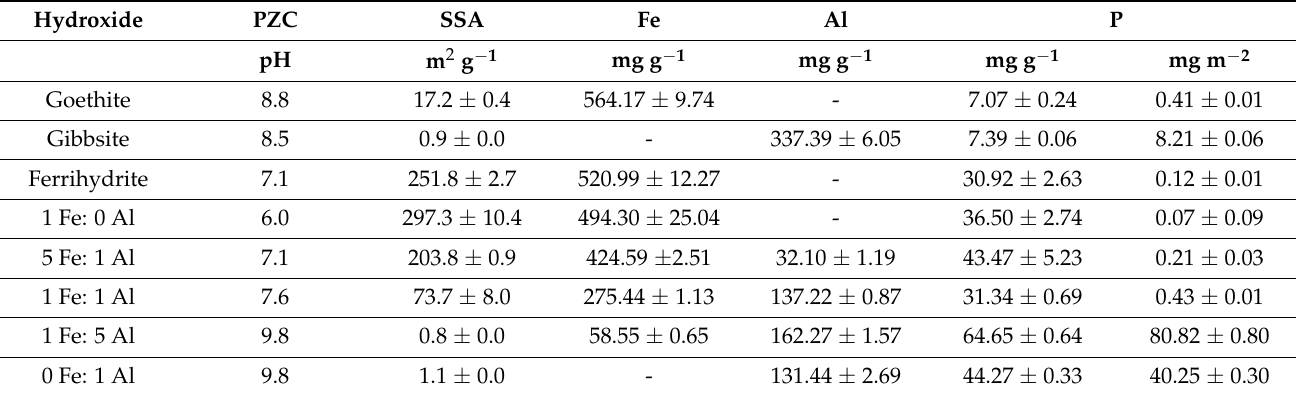
Table 1. Point of zero charge (PZC), specific surface area (SSA), and the amount of total Fe, Al, and P of crystalline and amorphous Fe- and